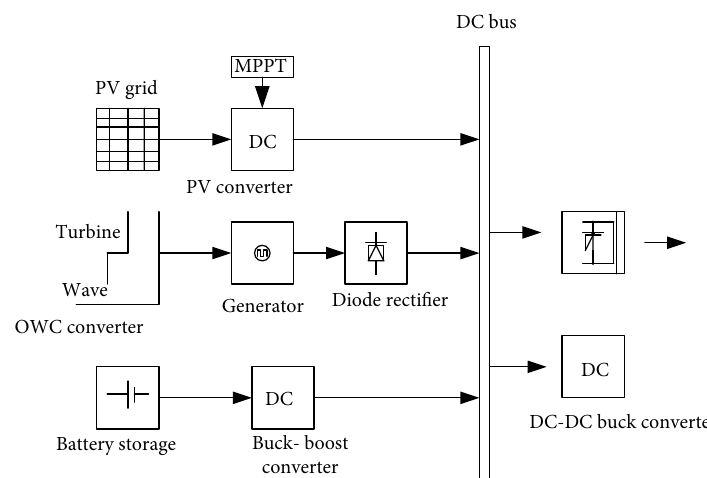
Figure 1: PV-wave proposed hybrid system block diagram.